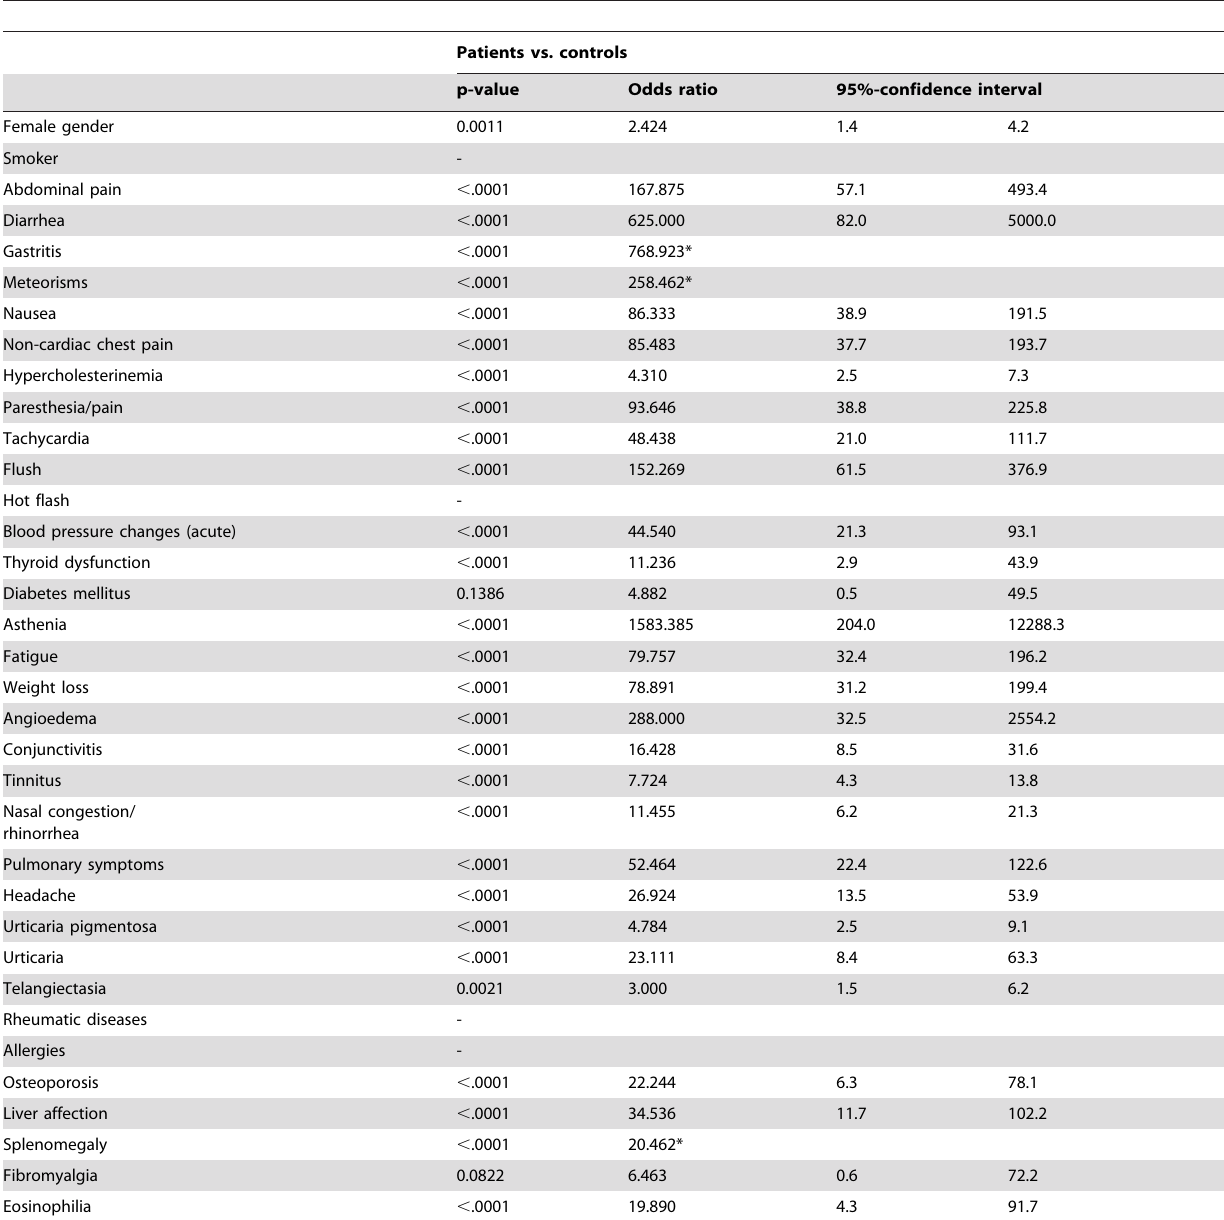
Table 3. Odds ratios for the symptoms and findings collected in the questionnaire (independent variables) occurring in patients, compared with the healthy control